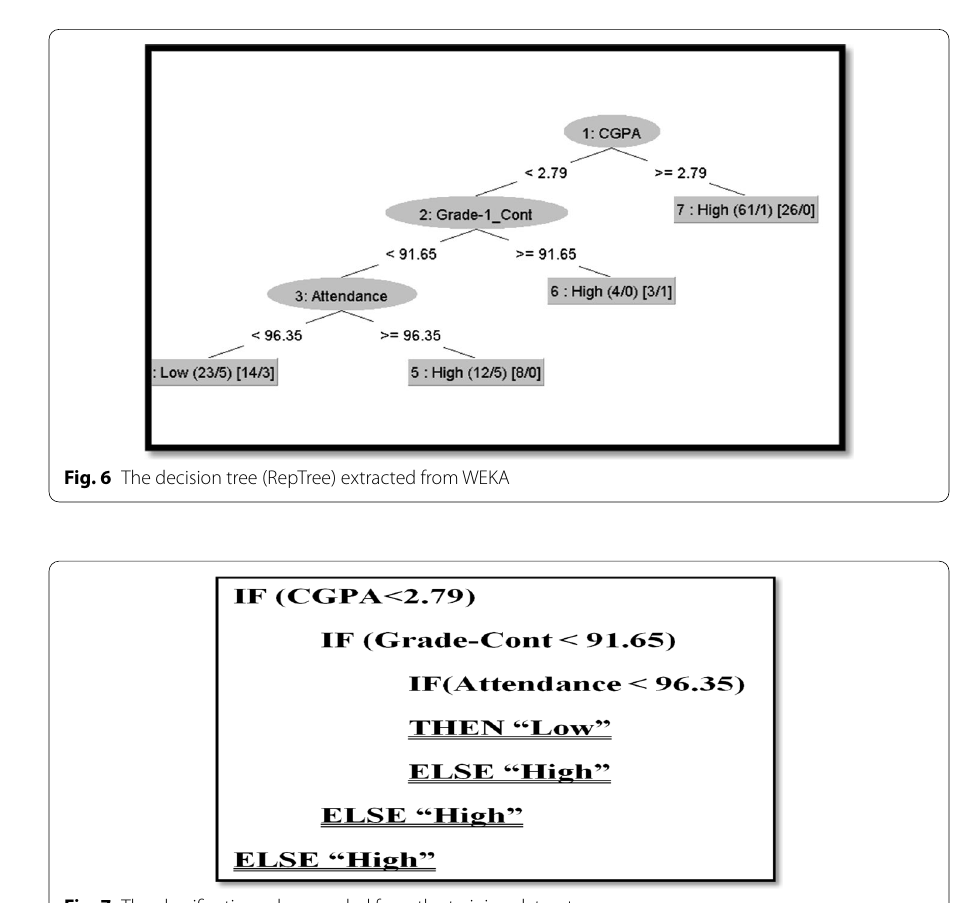
Fig. 7 The classification rules revealed from the training